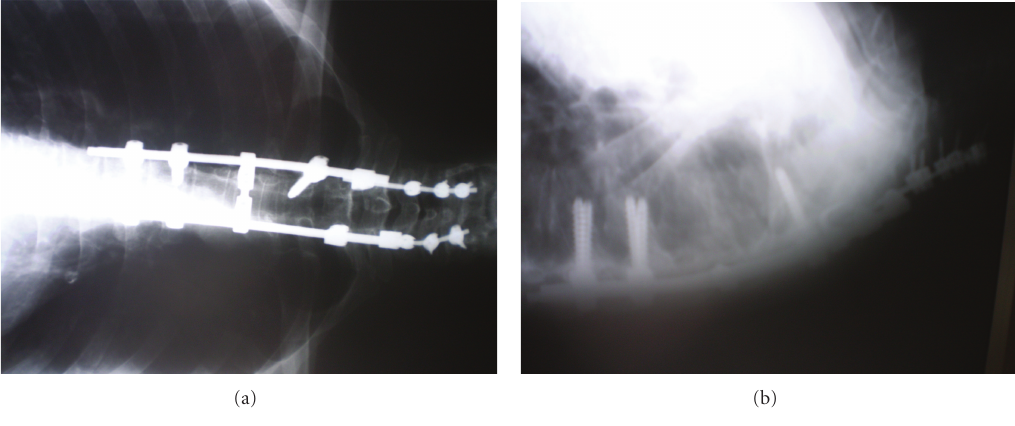
Figure 3: The postoperative plain X-ray.